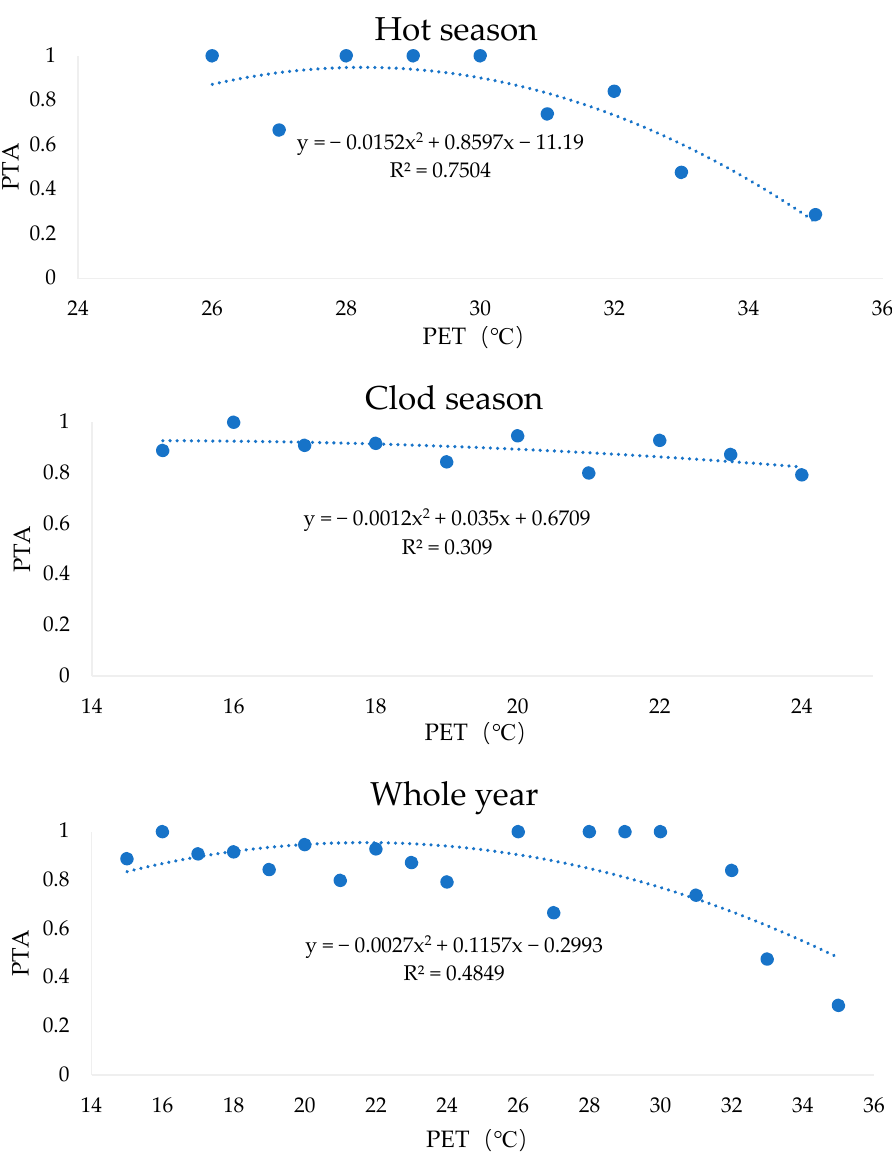
Figure 9. Relationship between PTA and PET.